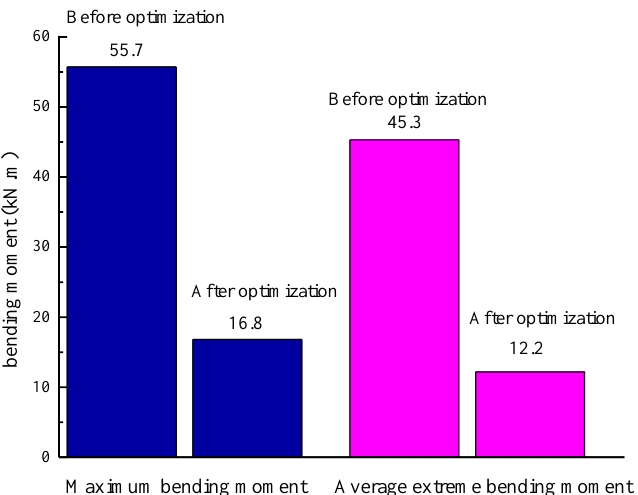
Figure 17. Comparison of bending moment of tunnel before and after adjustment.